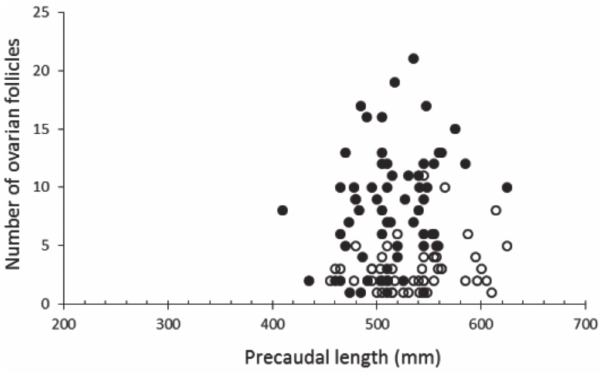
Fig. 6 . Relationship between precaudal length and total number of vitellogenic ovarian follicles (black circles) and atretic ovarian follicles (white circles) of Callorhinchus callorynchus